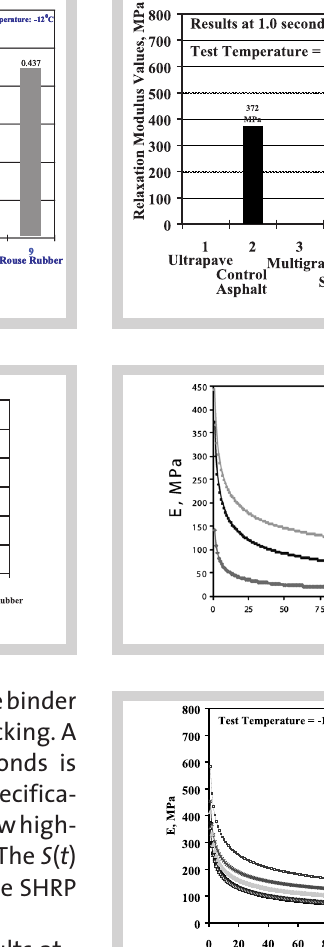
Figure 5 b) (left above): The m-value results at -12˚C. Figure 6 (left below): Comparison of measured S(t) values for asphalt binder samples at -12˚C. Figure 7 (right above): Binder relaxation modulus for control asphalt and modified binders at 1 second from BBR tests at -12˚C. Figure 8 (right middle): Relaxation modulus for control asphalt binder. Figure 9 (right below): Relaxation modulus for control asphalt and modified binders at